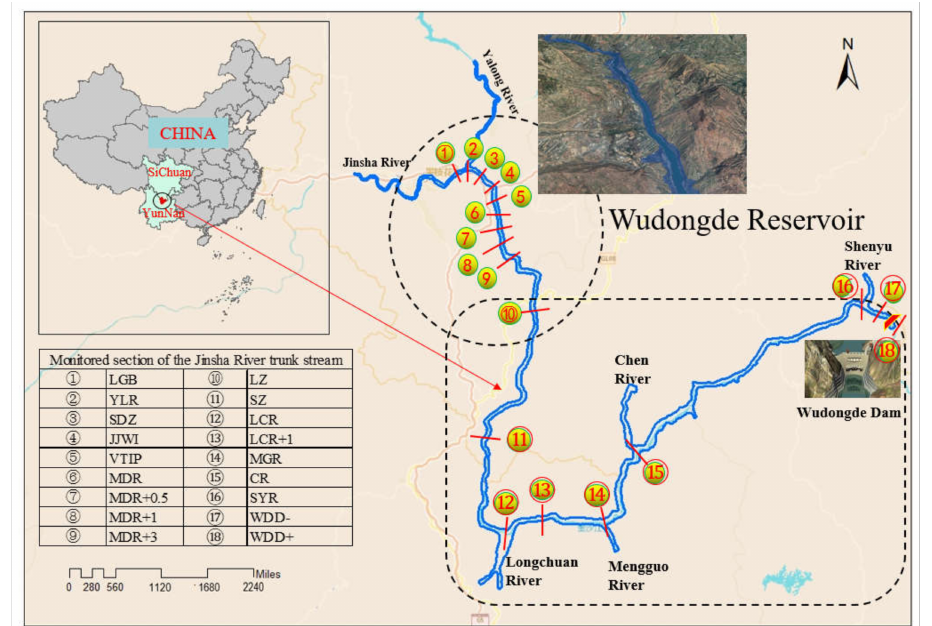
Figure 1. Layout of the monitored section of the main stream in the Wudongde Reservoir. Luoguo Bridge, LGB; Yalong River, YLR; Sanduizi, SDZ; Jinjiang Water Intake, JJWI; Vanadium Titanium Industrial Park, VTIP; Madian River, MDR; 0.5 km downstream of Madian River, MDR + 0.5; 1 km downstream of Madian River, MDR + 1; 3 km downstream of Madian River, MDR + 3; Lazha, LZ; Shizhuang, SZ; Longchuan River, LCR; 1 km downstream of Longchuan River, LCR + 1; Meng- guo River, MGR; Chen River, CR; Shenyu River, SYR; upriver from the Wudongde Dam, WDD-; downstream of the Wudongde Dam,